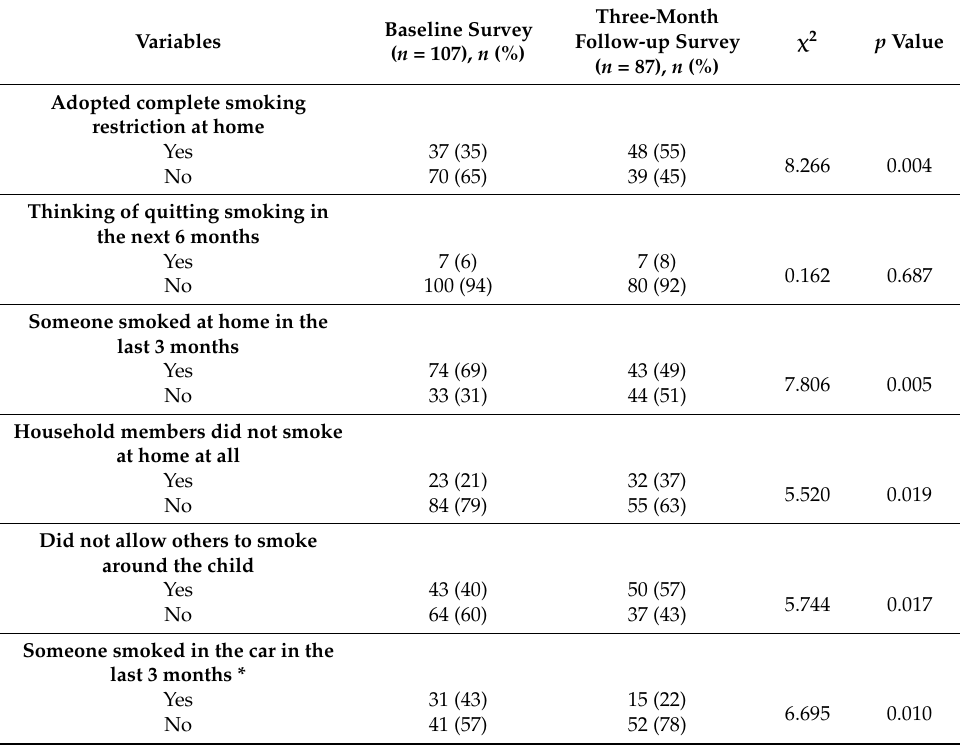
Table 2. Smoking status, quitting status, and secondhand smoke exposure reduction practices of the studied sample at the baseline and three-month follow-up